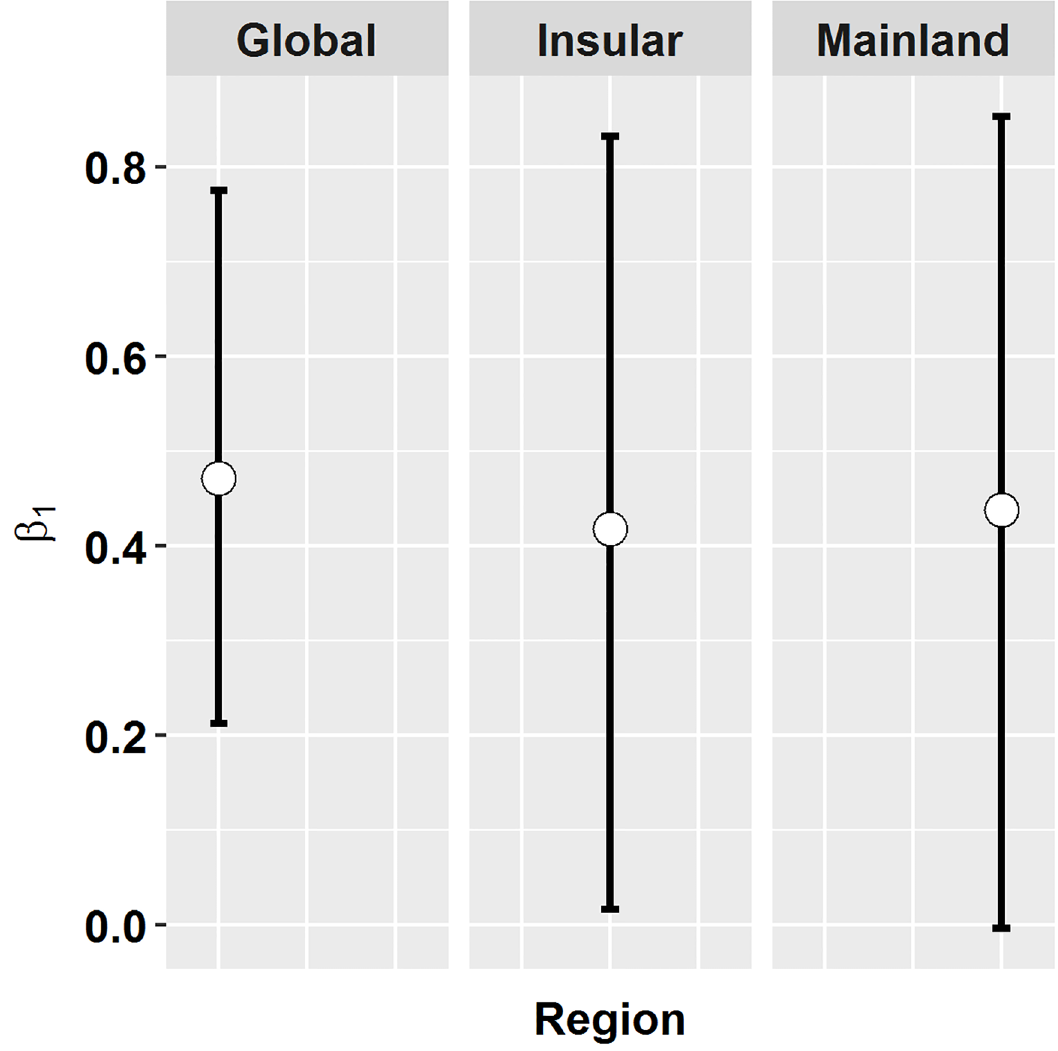
Fig 3. Estimated regression coefficients and 95% bootstrap confidence intervals for β 1 , relating the log expected catch rate to % tree cover. Regionalmodels were fit to data from either the insular and mainlandcountries, allowingthe responseof sun bears to tree cover to vary by region. The insular data, catch rate per camera trap, were modelledusing log-linearregression(Eq 1) and the mainland data, detection/non-detection per camera trap within a trappingperiod, were modelled using a binary regression model with complementary log-loglink (Eq 2). The globalmodel pooledall data, assuming bears respondedsimilarlyto tree cover throughoutthe range, and modelleddetection/non-detection per camera trap within a trappingperiodusing the binary regressionmodel (Eq 2). Models assumed log catch rate of sun bears at camera traps was a linear function of tree cover averagedover a 6-km 2 circulararea surroundingthe camera traps. Data were filtered to reduce variability in samplingintensity, by removingcameras active for < 7 days and > 90 days, and study sites with < 10 cameras.